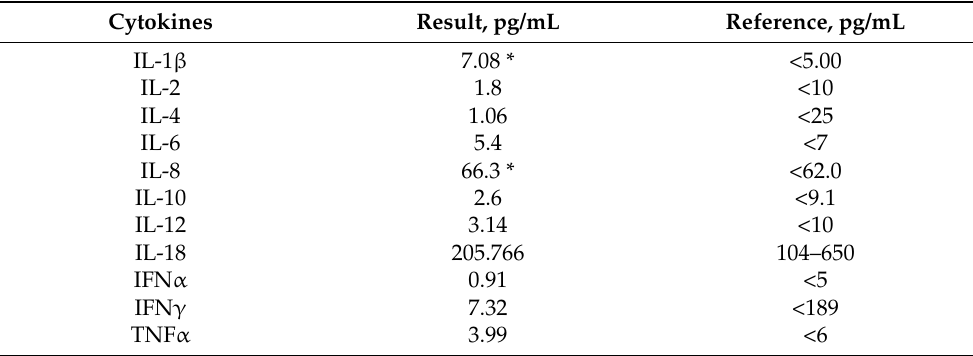
Table 1. Levels of cytokines in a female suffering from cervix endometriosis. Cytokines Result, pg/mL Reference, pg/mL IL-1